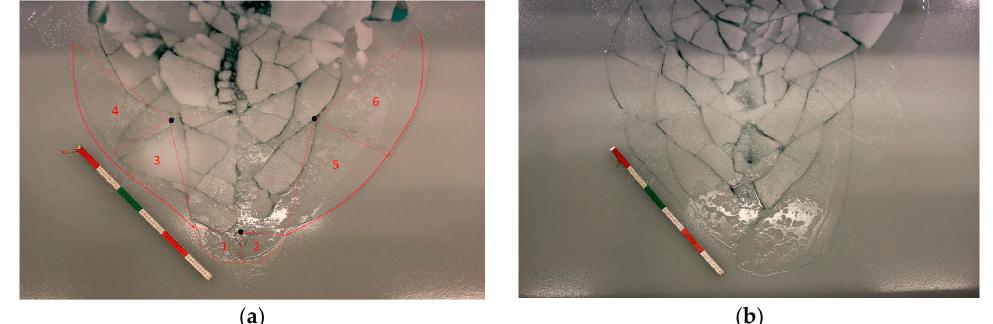
Figure 13. Two examples of Ice breaking pattern captured from ice model test (In Appendix B of AARC